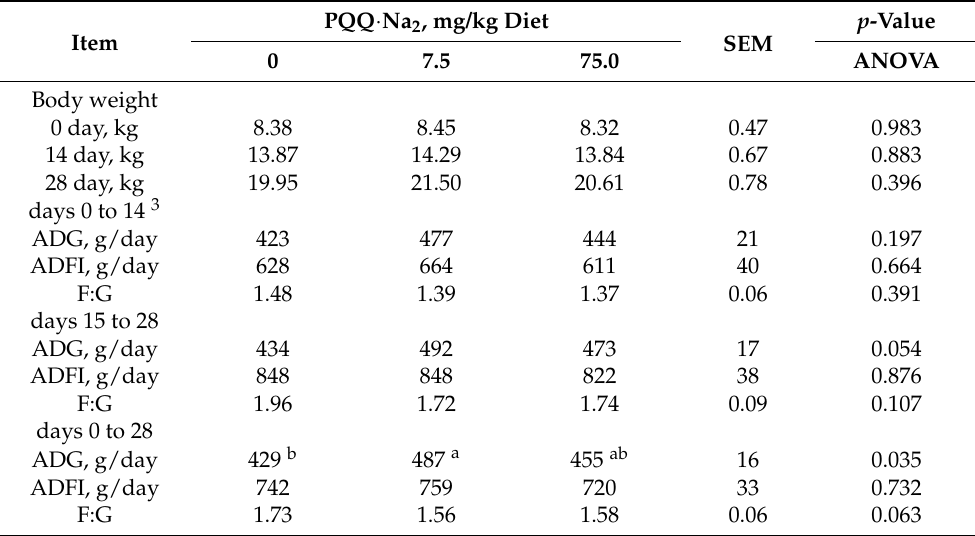
Table 2. Performance of weaned pigs fed graded levels of PQQ · Na 2 1 for 28 day 2.